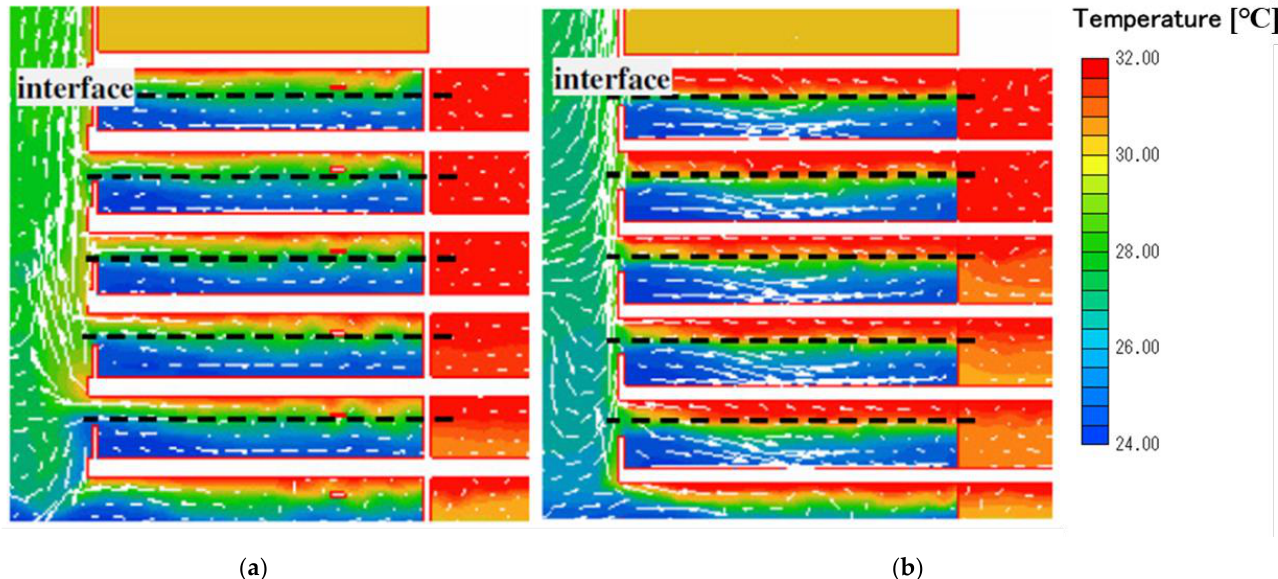
Figure 23. Temperature distribution with various ceiling heights (heat source at 1.5 m when SA at 1.1 m). ( a ) 2.15 m ceiling height. ( b ) 2.45 m ceiling height.